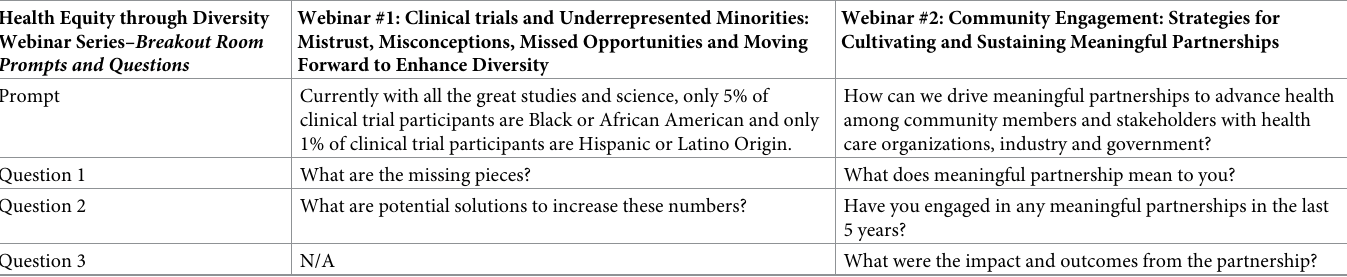
Table 2. Health Equity through Diversity webinar series– breakout room prompts and questions . Health Equity through Diversity Webinar Series– Breakout